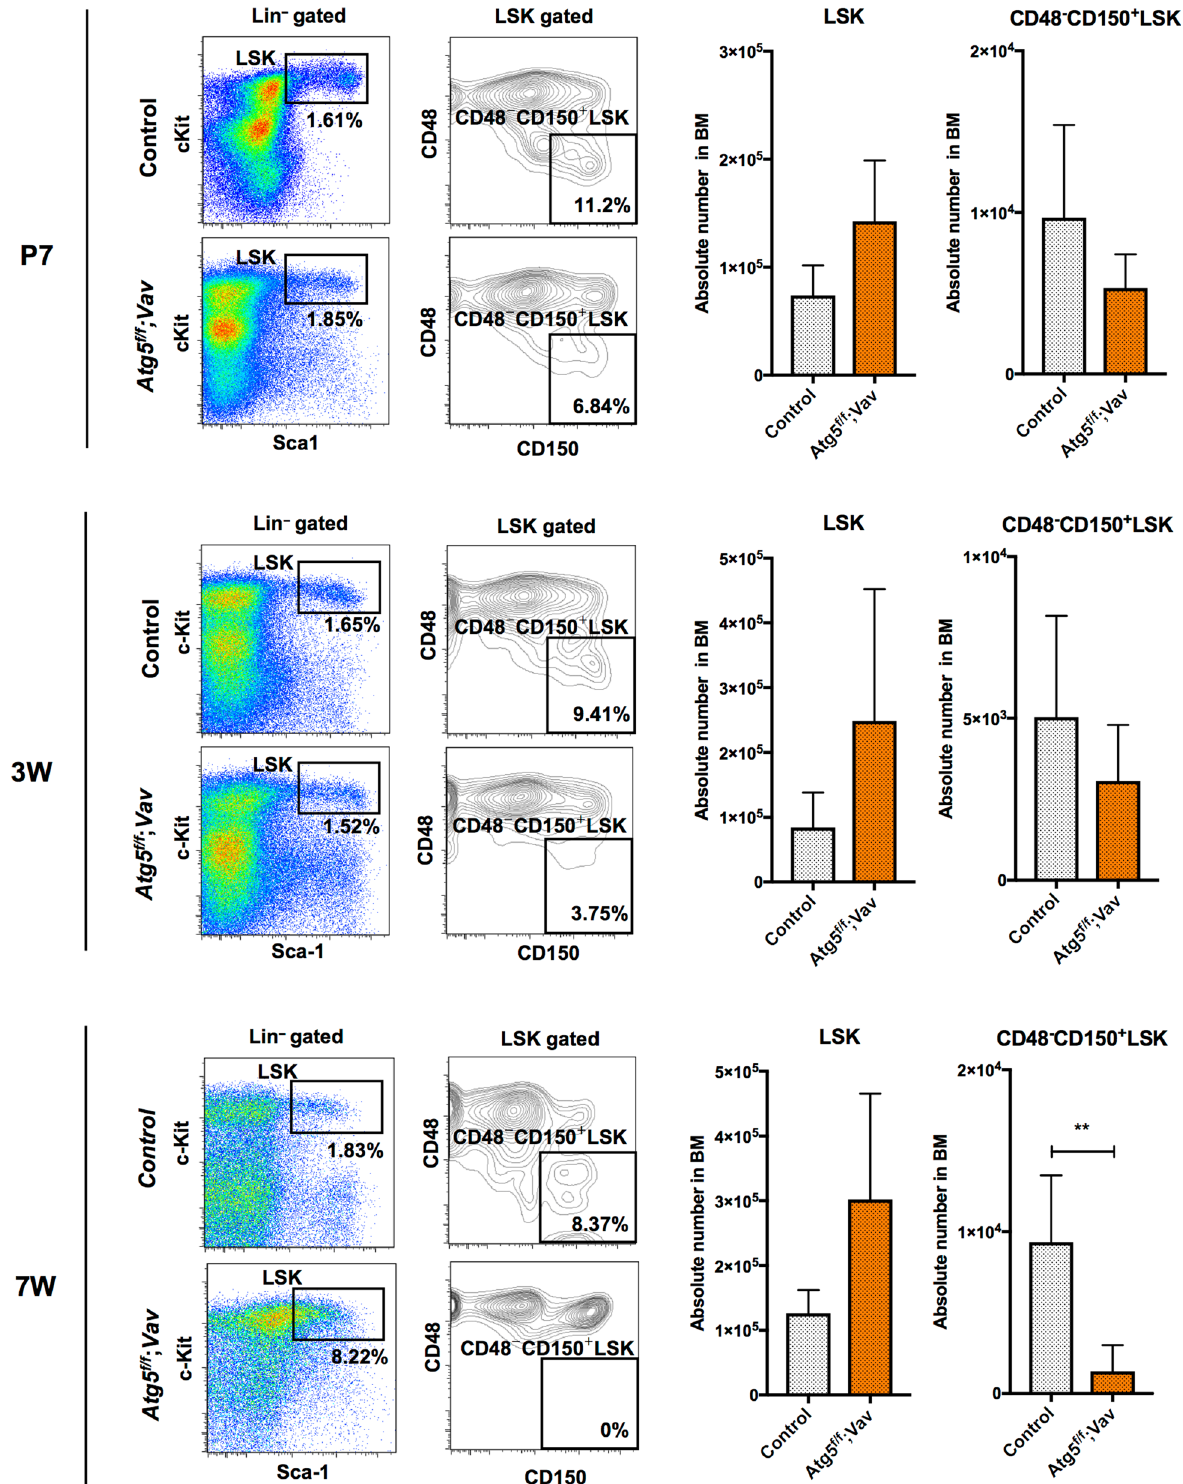
Figure 1. HSC population in control ( Atg5 f / w ; Vav ) and Atg5 f / f ; Vav mice at P7 (top), 3 weeks (middle), and 7 weeks (bottom). Left panel shows a representative flow cytometric plot of LSK (Lin − c-Kit + Sca1 + ) cells and CD48 − CD150 + LSK cells in at least three independent experiments. Right panel shows absolute numbers of LSK and CD48 − CD150 + LSK cells. Data are the mean ± SD (n =